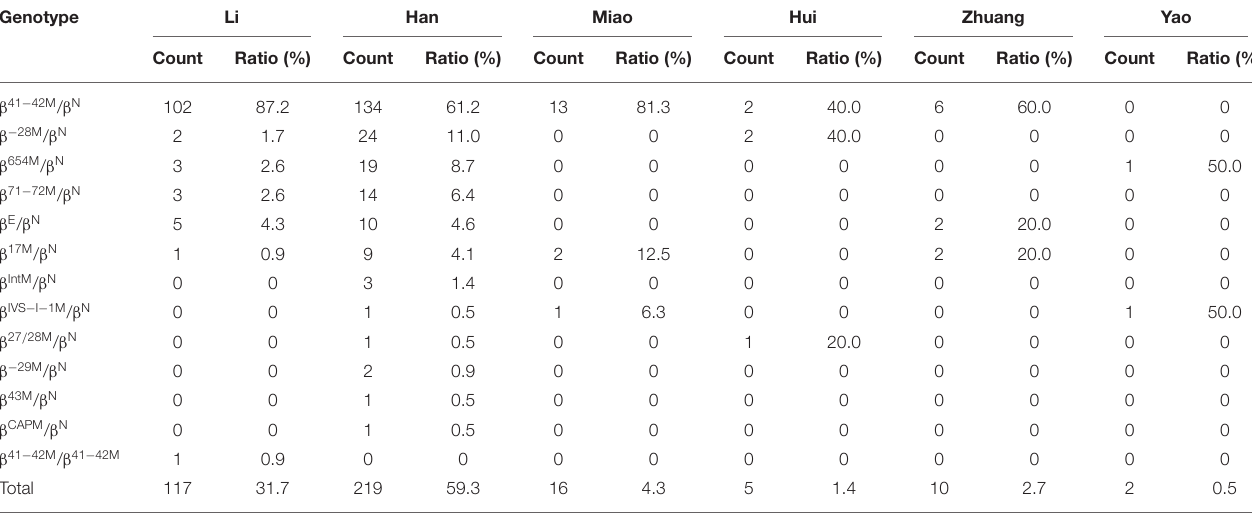
TABLE 7 | Distribution of β -thalassemia genotypes in the Han people and ethnic minorities in the southern area of Hainan. Genotype Li Han Miao Hui Zhuang Yao